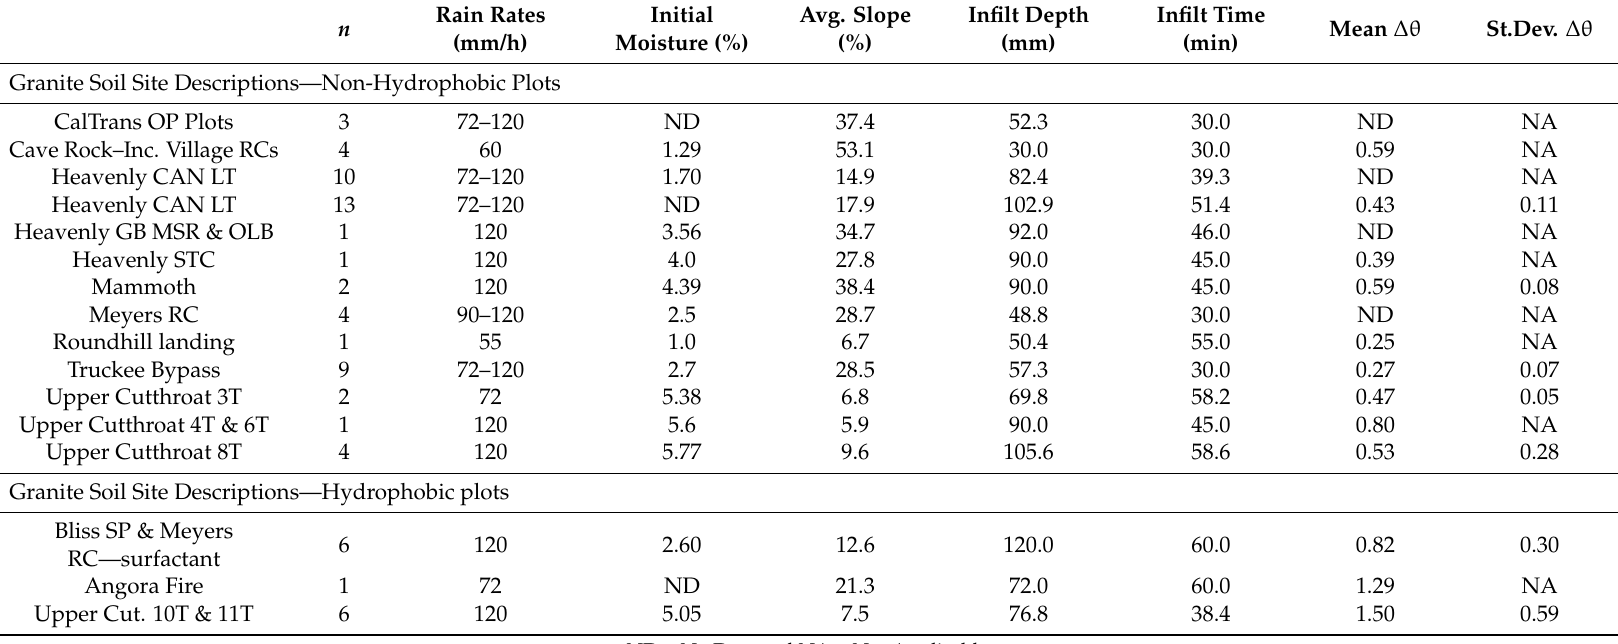
Table 5. Summary of RS plot setting data averages for granitic soil plots not generating runoff.